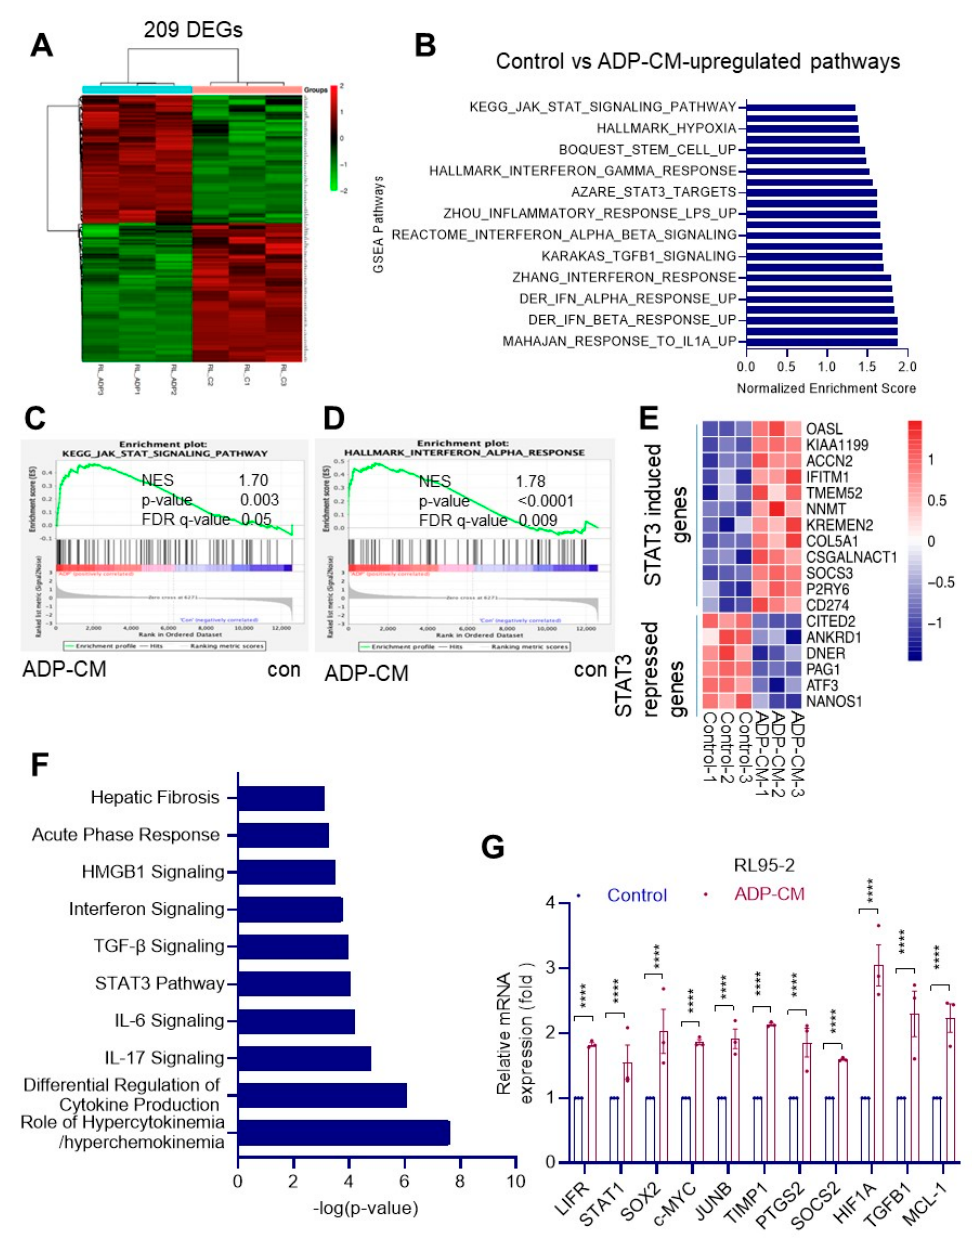
Figure 1. Global RNA-seq analysis of RL95-2 cells treated with ADP-CM identified unique path- ways. ( A ) Heatmap showing differentially expressed genes upon ADP-CM treatment with |FC |